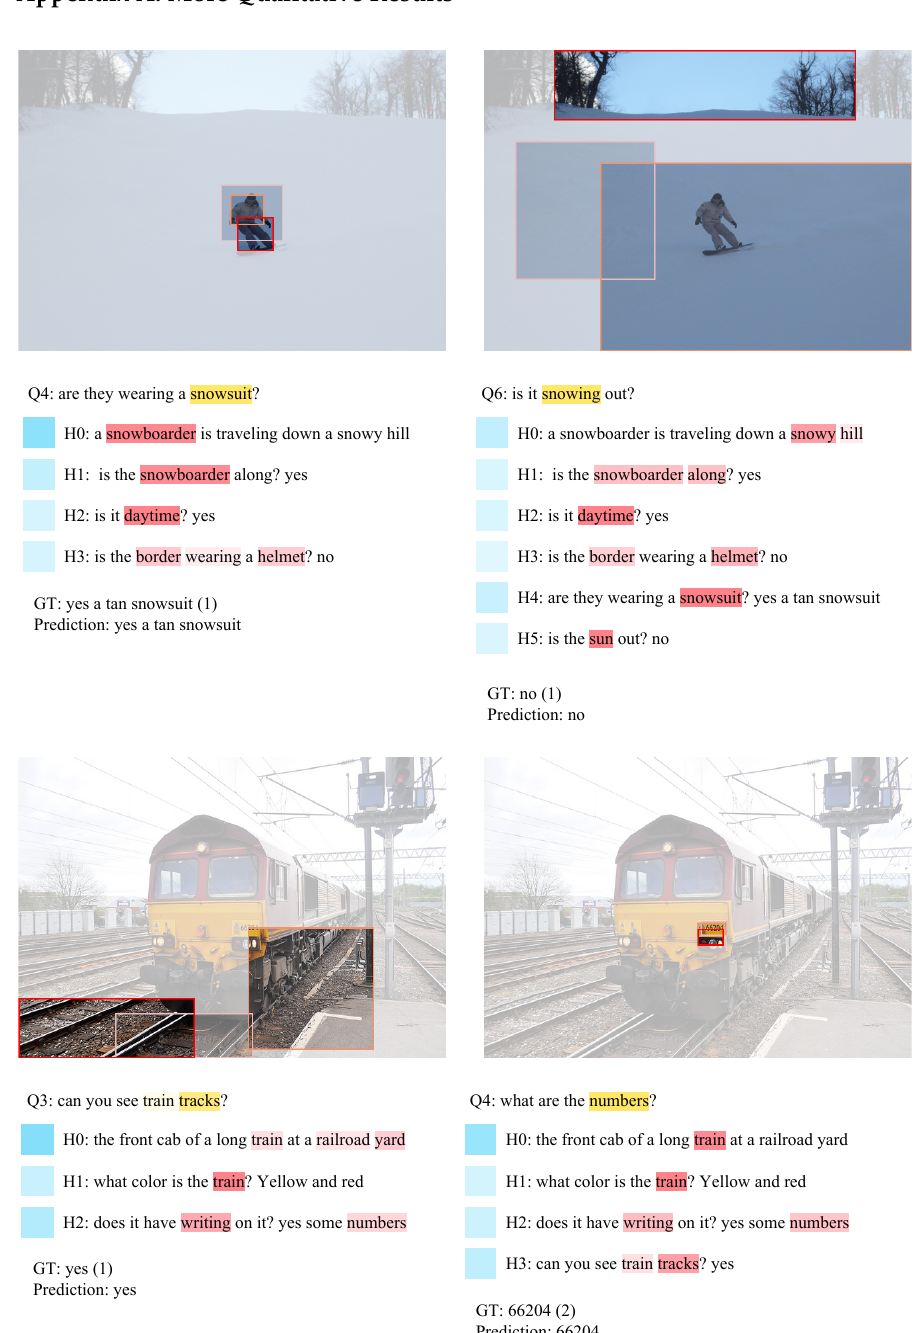
Figure A1. Visualization of the reasoning process for each module in